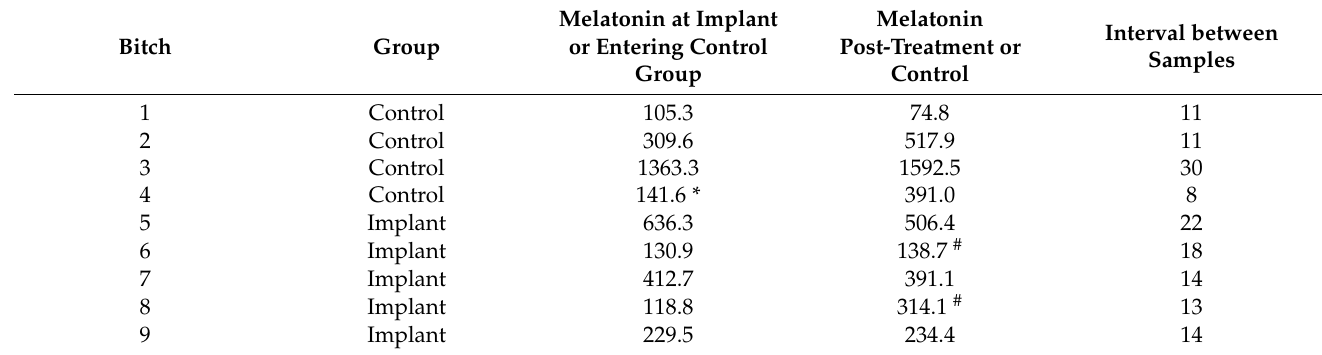
Table 2. Serum melatonin concentrations (pg/mL) in individual bitches in relation to